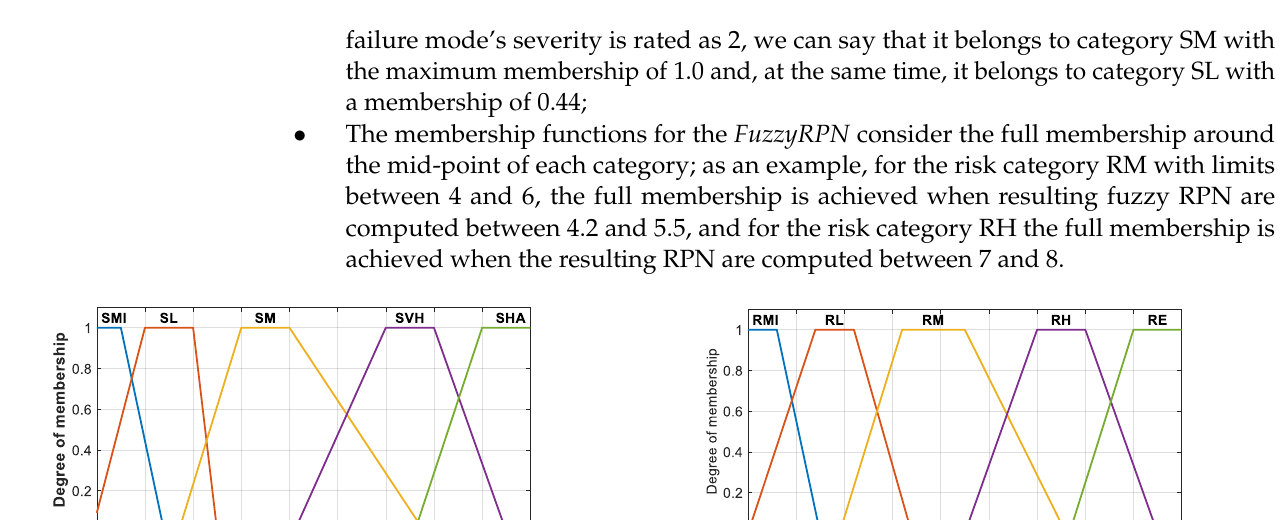
Table 7. Type-I trapezoid membership functions for the FMECA risk factors.